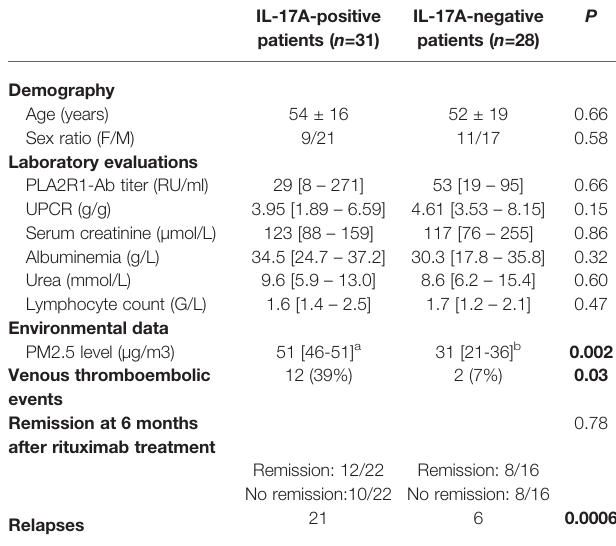
TABLE 2 | Characteristics of MN patients according to interleukin-17A level. IL-17A-positive patients ( n